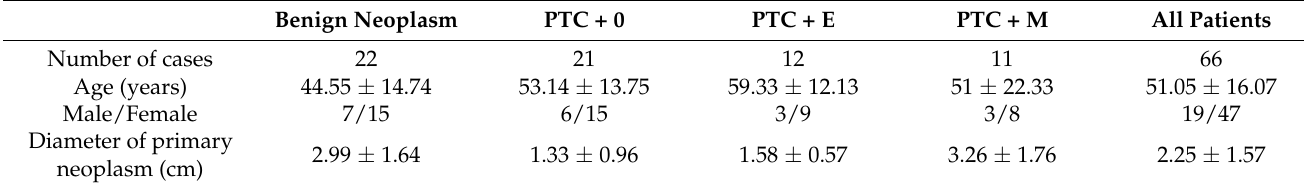
Table 1. Patients’ demographics and neoplasm characteristics.